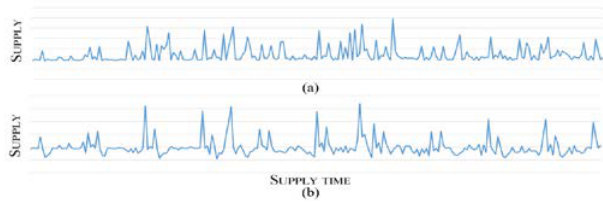
Fig. 2. Raw data (a), Preprocessed data (b).